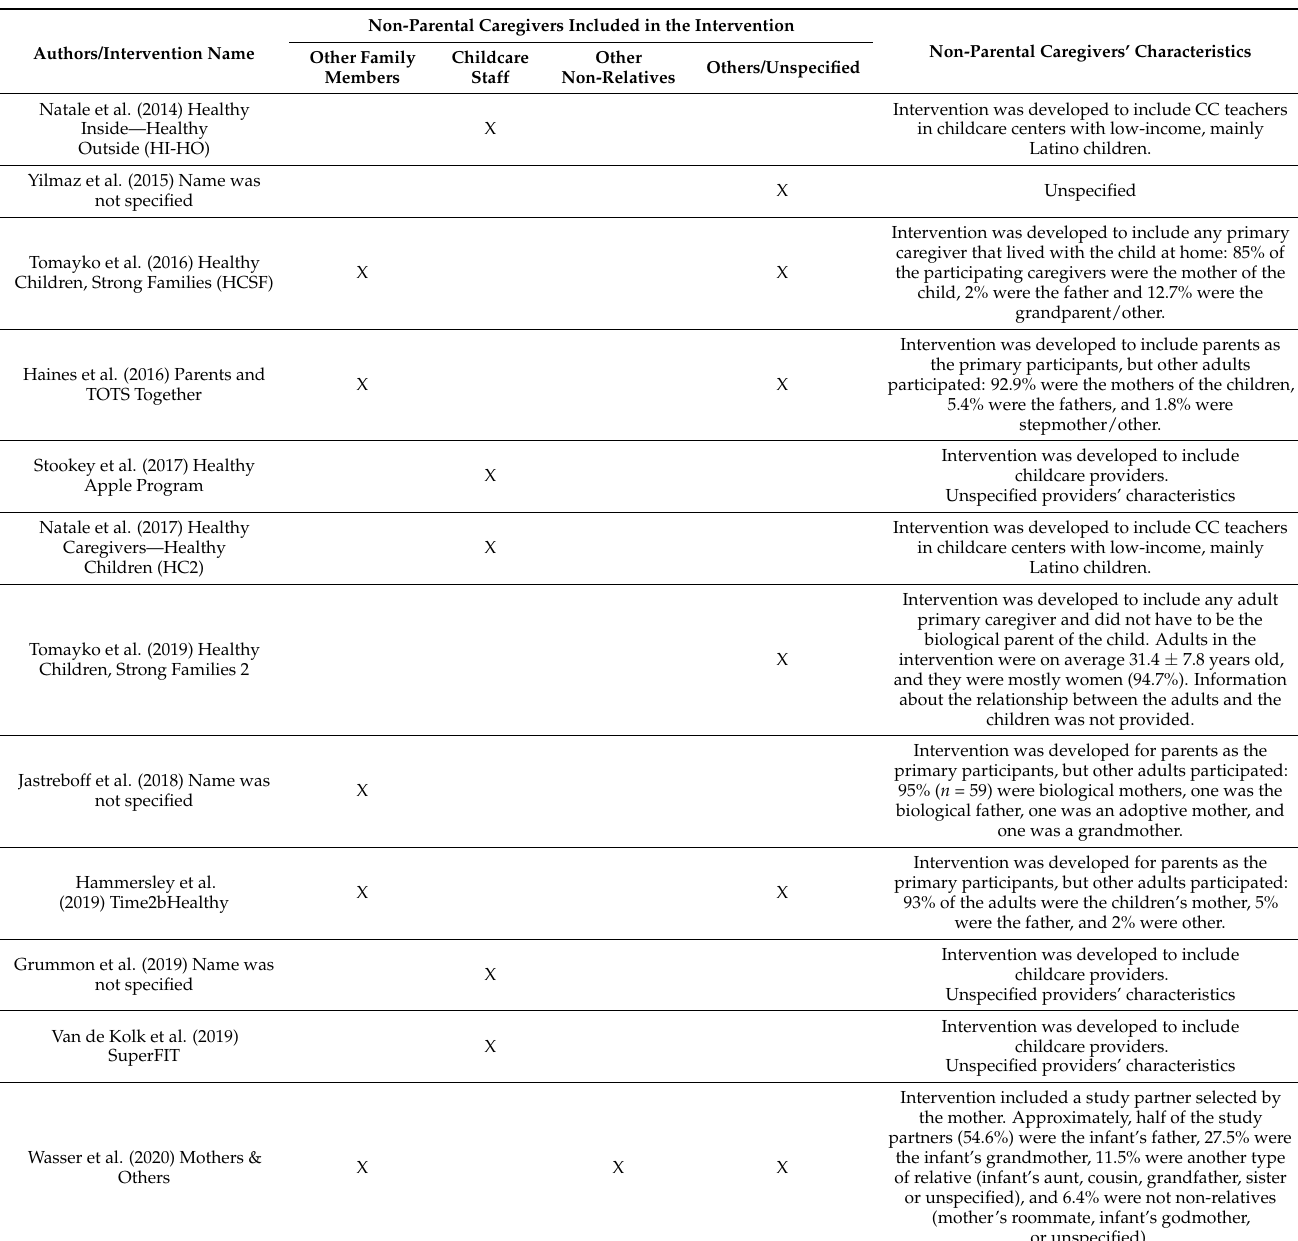
Table 4. Role and characteristics of the non-parental caregivers in the